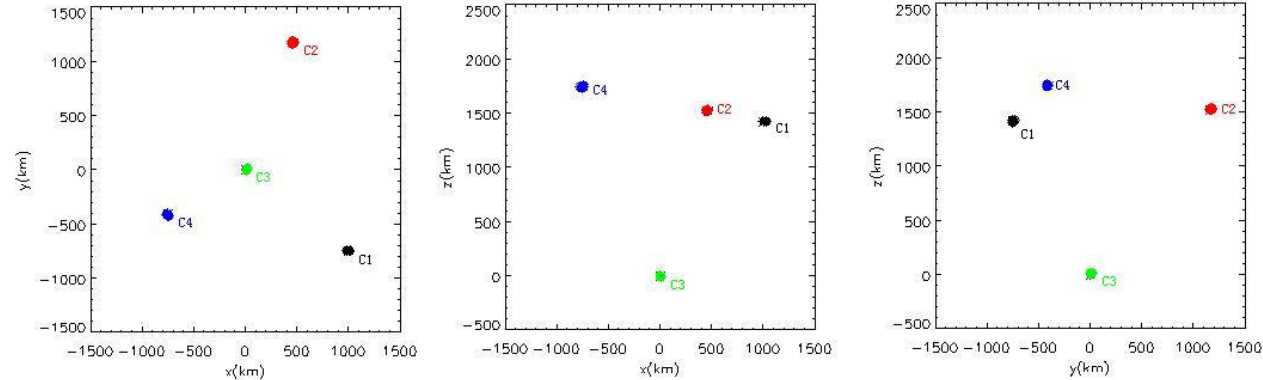
Fig. 1. The configuration of Cluster tetrahedron in the time interval 04:40–05:10UT on 15 September